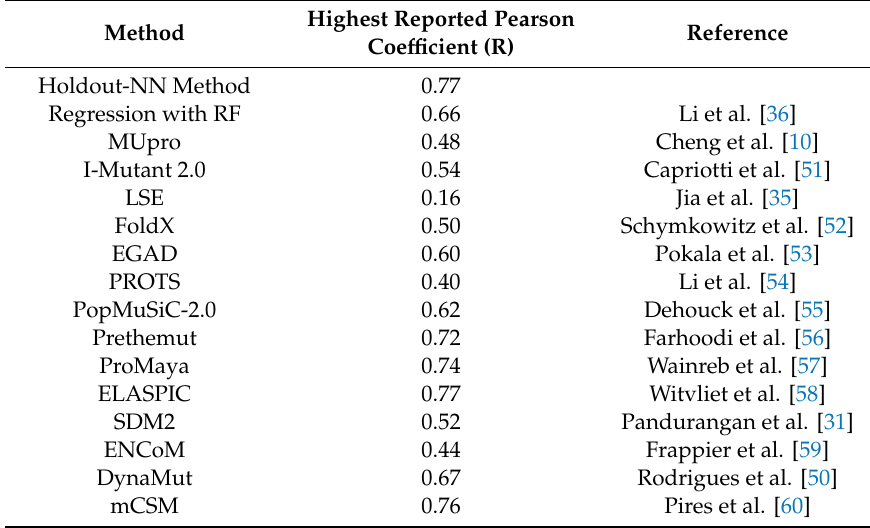
Table 1. Overall Performance of Holdout-NN sampler in comparison with the performance of other commonly used methods.